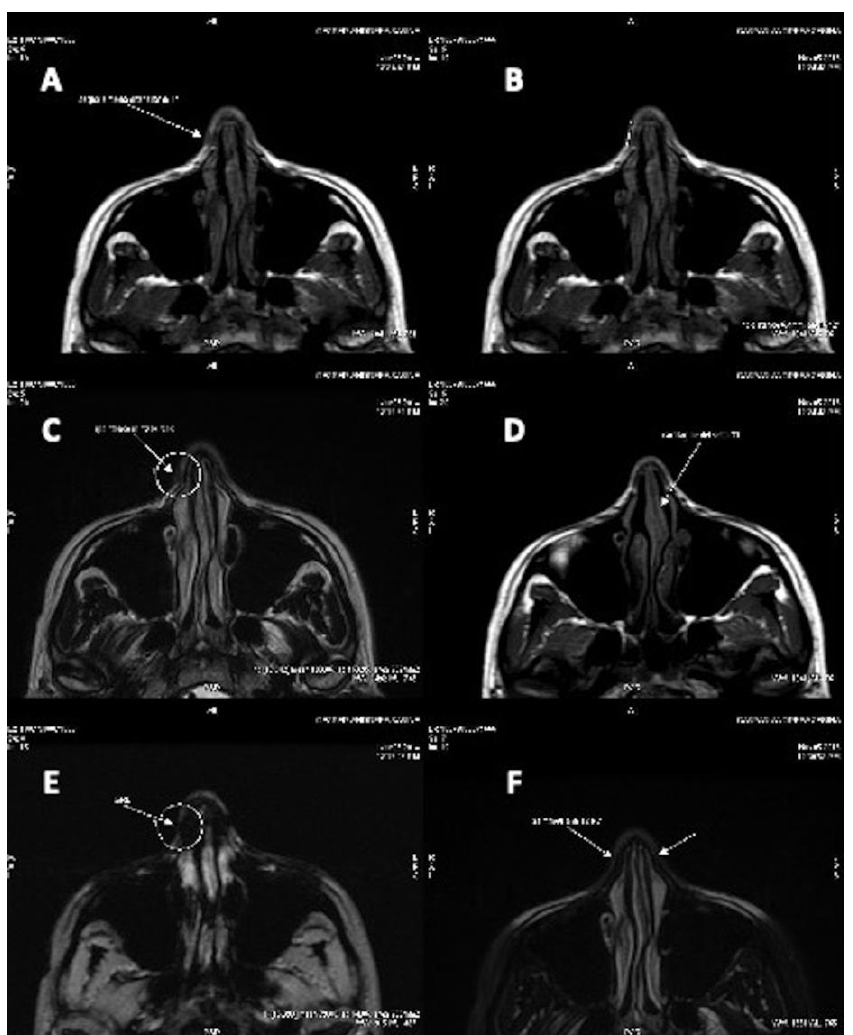
Figure 7. Computerised tomographic (CT) scans of patient showed in Figure 4. ( A , C , E ) Pre-operative situation. ( A ) CT scans, T1 medium signal intensity, showed the pre-operative situation with soft tissue defect of the nasal tip and nasal septum deviation. ( B ) CT scans, T1 medium signal intensity, showed the post-operative situation with an improvement of soft tissue volume in the treated area. ( C ) CT scans, T2 high signal intensity, showed the pre-operative situation in detail, with cartilage defect and nasal valve collapse. ( D ) CT scans, T2 high signal intensity, showed the post-operative situation with correction of the nasal valve collapse. ( E ) CT scans, T2 high signal intensity, showed the detail of the pre-operative situation with soft tissue defect of the nasal tip and cartilage defect in detail. ( F ) CT scans, T2 high signal intensity, of the same area after 12 months show the regenerated site in the post-operative image with soft tissue volume improvement and the correction of the nasal septum deviation.